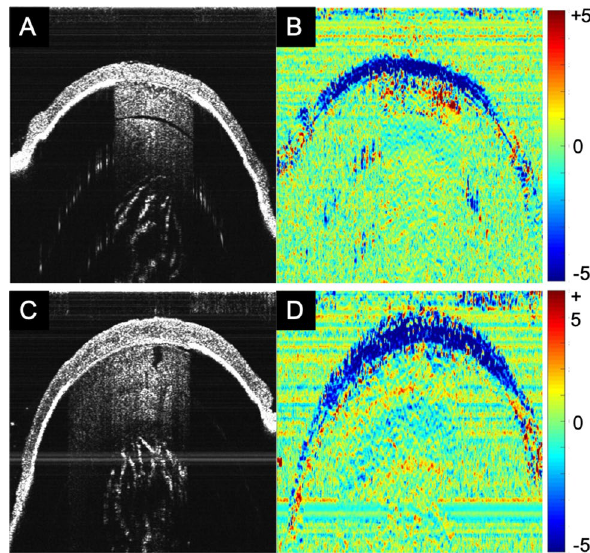
Figure 1. Structural image ( A , C ) and strain map ( B , D ) obtained from OCT. Col5a1 +/− eyes ( A , B ) had a thinner corneal thickness than wild-type eyes ( C , D ), but a similar axial strain distribution.